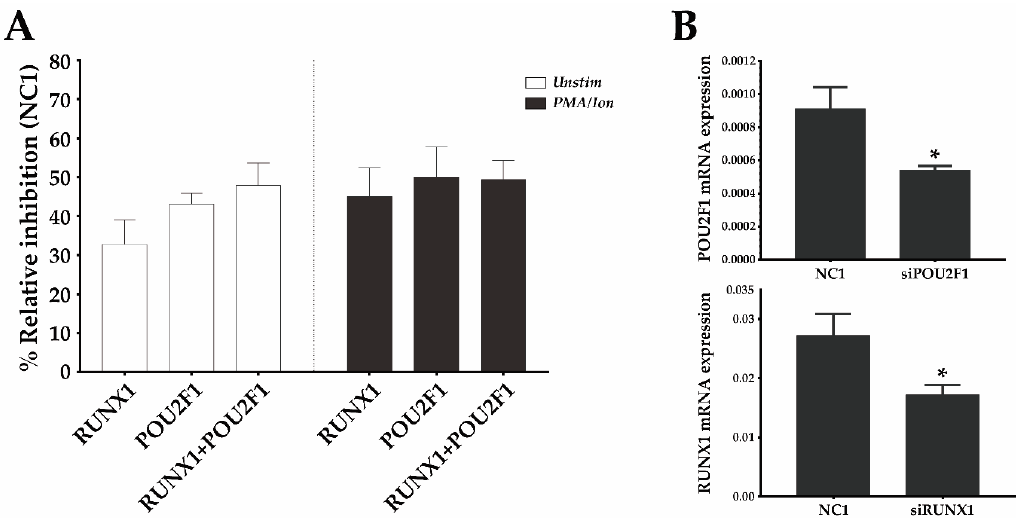
Figure 5. RUNX1 and Oct1 ( POU2F1 ) silencing downregulates mouse CD69 protein expression. ( A ) EL-4 T cells were transfected with a 1 µ M pool of three DsiRNAs against RUNX1 , POU2F1 (Oct1), a combination of both, or a non-targeting DsiRNA (NC-1) and were cultured for 16 h. They were then stimulated or not stimulated with PMA / Ion, and the CD69 surface levels were measured 6 h later. The bars represent the mean ± SEM of the % relative inhibition with respect to CD69 expression in the NC-1 control of 2 di ff erent experiments in which each transfection was performed in duplicate. ( B ) mRNA expression of RUNX1 and POU2F1 was analyzed by qPCR 22 h after DsiRNA transfection, compared with the NC1 DsiRNA control. Data are presented as means ± SD of two independent experiments (* p <